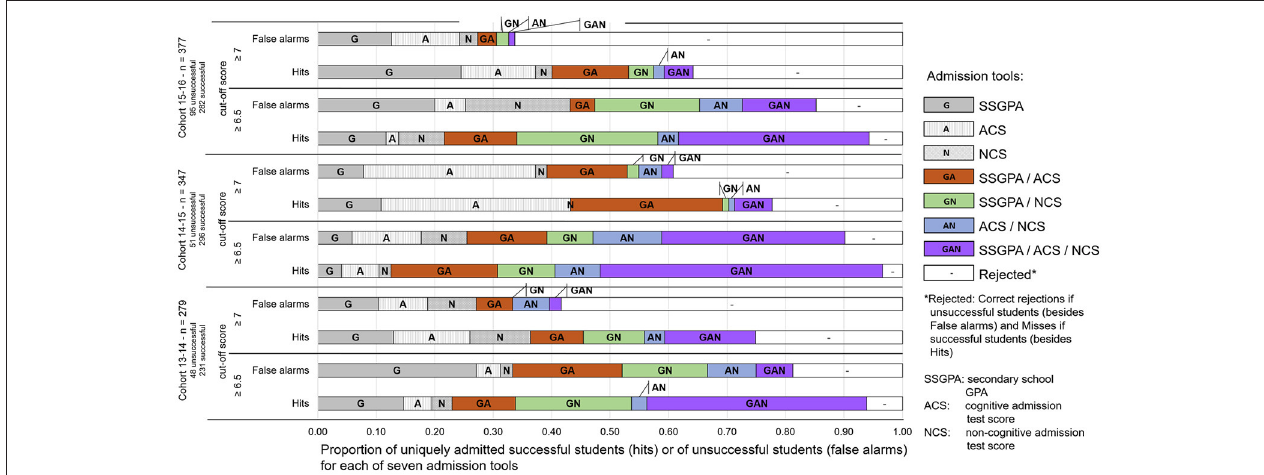
FIGURE 5 | Proportions of unique hits and false alarms, Total Misses and Total Correct Rejections for a set of seven admission tools, with criteria ≥ 6.5 and ≥ 7 applied. For each applicant, we determined whether they scored at or above criterion on SSGPA-only, ACS-only, and NCS-only. These were the “single” tools. Another three “double” tools were constructed to determine whether students had scored at or above criterion on both-SSGPA-and-ACS-but-not-NCS, both-SSGPA-and-NCS-but-not-ACS and both-ACS-and-NCS-but-not-SSGPA. From the three single admission tools, we constructed “SSGPA/ACS/NCS” which determined whether students scored at or above criterion on all three single predictors (SSGPA and ACS and NCS) and not on only one or two of the three. “Hits” are successful students who would have been selected with the given tool and criterion and “false alarms” are unsuccessful students who would have been selected with the given tool and criterion. “Total Misses” are successful students who are not selected by any admission tool in this set with the given criterion and “Total Correct Rejections” are unsuccessful students who are not selected by any admission tool in this set with the given criterion. Each student contributes to only one proportion for each criterion ( ≥ 6.5 and ≥ 7) in their cohort: each student in each cohort, and for each of both criteria, is a hit or false alarm for only one of the seven tools OR a total miss or total correct rejection. The proportions of unique hits (of total successful students) and unique false alarms (of total unsuccessful students) were calculated for each of the tools in the set of seven tools as described above. These seven proportions of unique hits plus the Total Misses sum up to 1 (100% successful students). The seven proportions of unique false alarms plus the Total Correct Rejections sum up to 1 (100% unsuccessful